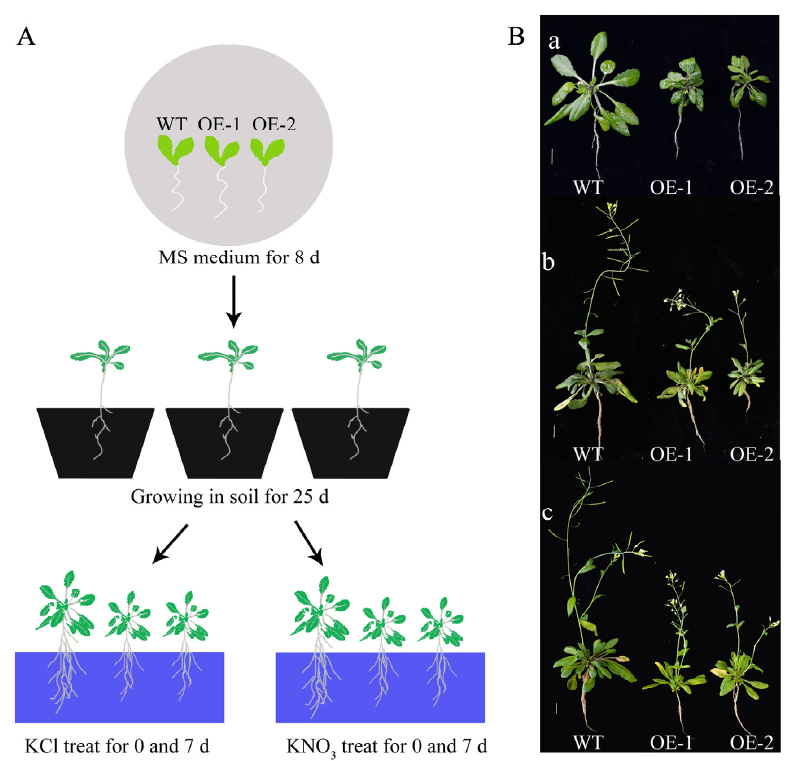
Figure 8. Effects of KCl and KNO 3 treatments on growth of WT and transgenic Arabidopsis plants hosting CsLBD39 gene. ( A ) Graphical abstract of the growth conditions of Arabidopsis . ( B ) The phenotypes of WT and transgenic Arabidopsis , ( a ) treats for 0 d, ( b ) KCl treatment for seven days, ( c ) KNO 3 treatment for seven days, Bar = 1 cm.